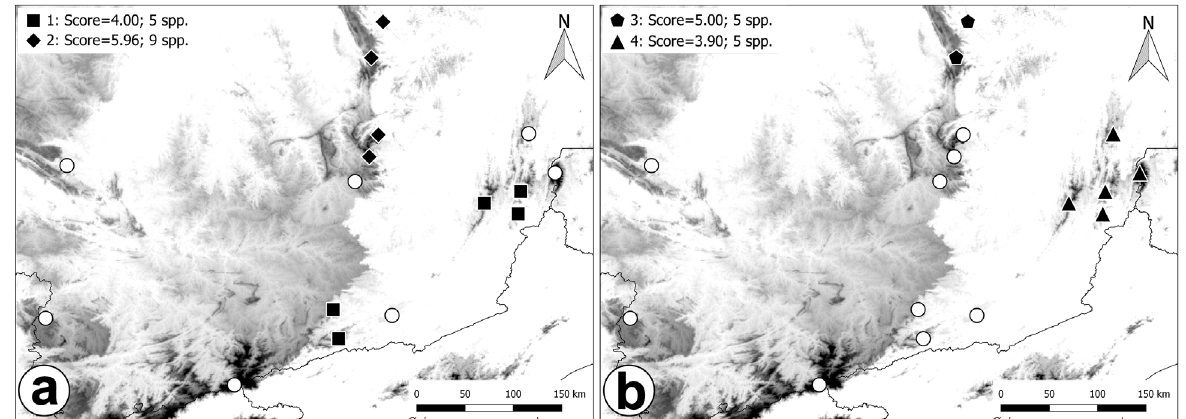
Figure 3 - The four areas of endemism generated by EA with their scores and number of species, separated in two maps: ( a ) Area of endemism one with PE do Ibitipoca, Serra Negra, Pedra Dourada, Serra do Brigadeiro and Municipality of Divino, and area of endemism two with Floresta Estadual do Uaimií, Serra do Caraça, Serra do Cipó and Microregion of Conceição do Mato Dentro. ( b ) Area of endemismo three with Serra do Cipó and Microregion of Conceição do Mato Dentro, and area of endemismo four with Pedra Dourada, Serra do Brigadeiro, Municipality of Divino, Serra do Caparaó and Municipality of